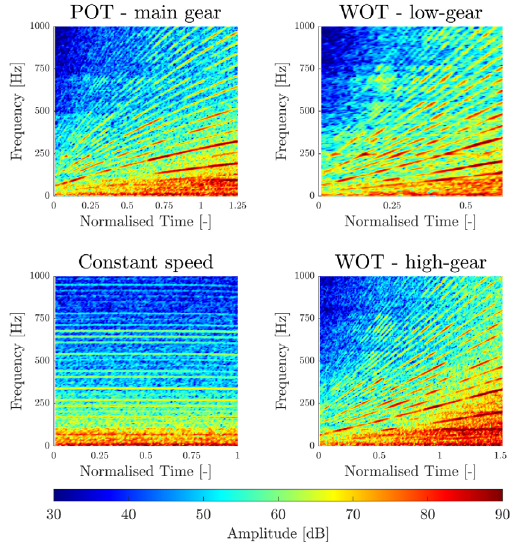
Figure 6. Normalised spectrogram of the sound pressure level measured at one of the headrest microphones during the POT manoeuvre in the main gear.